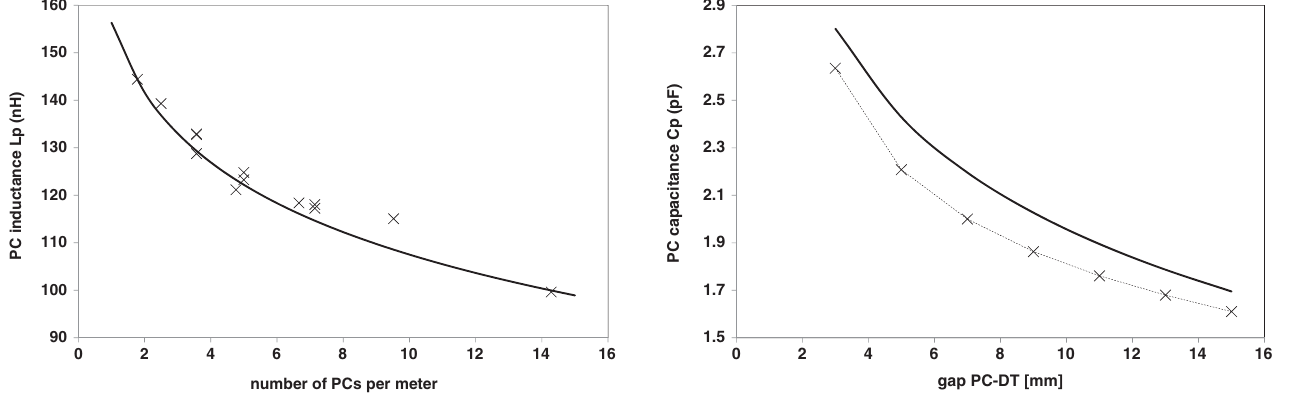
FIG. 9. PC capacitance C as a function of the number of PCs p solid line is given by the C formula, crosses are p 3D simulations in quasistatic